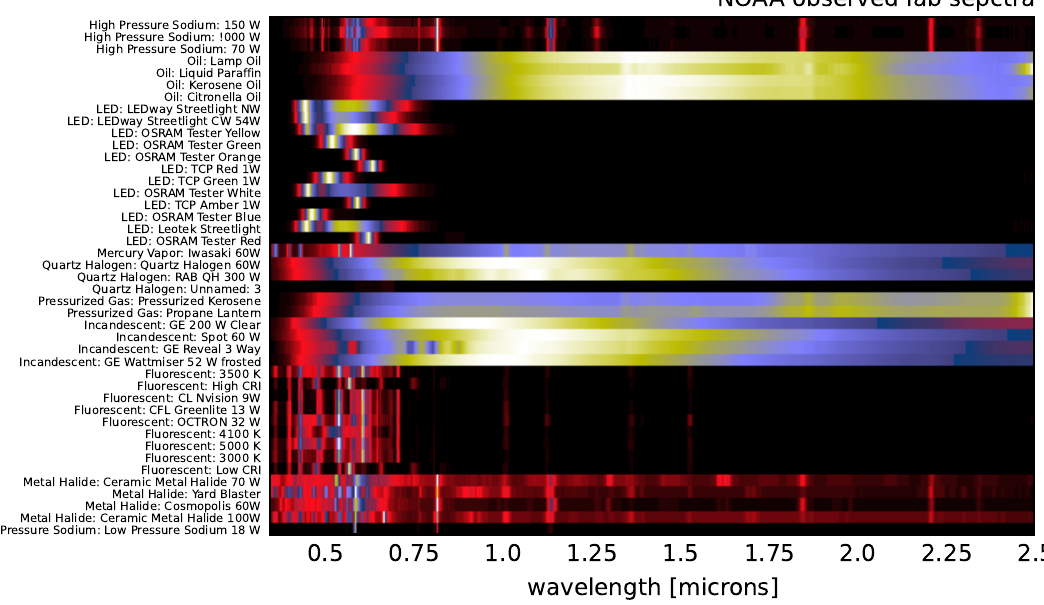
Figure 7. The 43 NOAA spectra measured by [43] in the lab. The wavelength range of 0.4–2.5 µ m extends beyond the range of the instrument used in this work, though the resolution of one nanometer is comparable to our VNIR